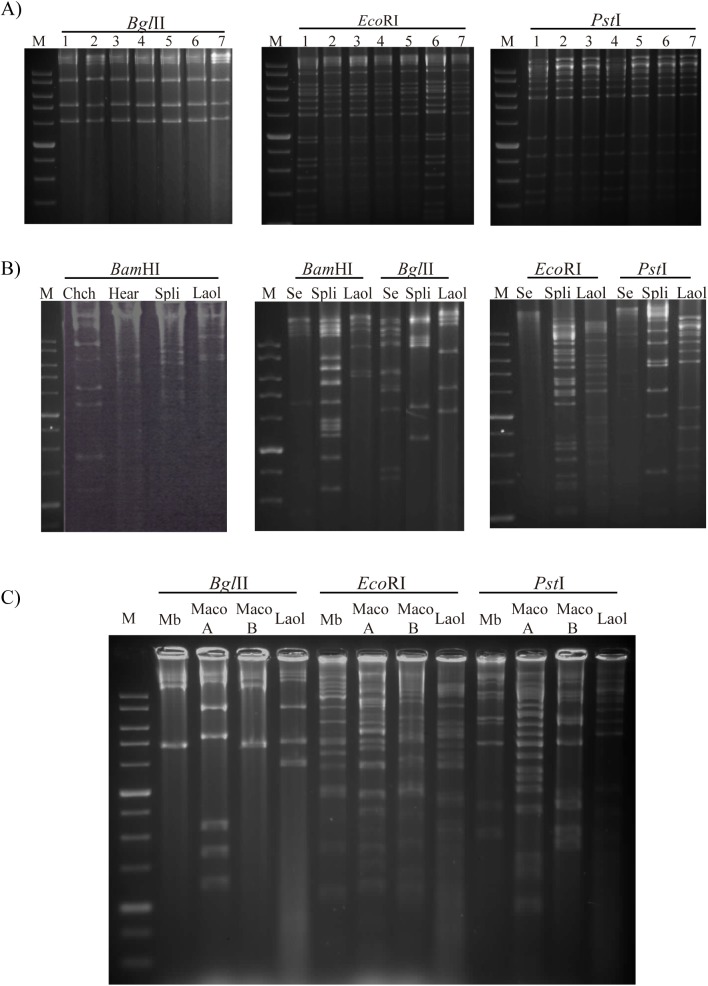
Restriction endonuclease analysis of LaolNPV DNA.Restriction endonuclease profiles following digestion of A) genomic DNAs of the seven isolates of LaolNPV collected in alfalfa crops nearby Montpellier with BglII, EcoRI and PstI enzymes, B) genomic DNAs of Chrysodeixis chalcites NPV (Chch), Helicoverpa armigera SNPV (Hear), Spodoptera littoralis (Spli), Spodopera exigua MNPV (Se) and the virus under study (LaolNPV) with BamHI, BglII, EcoRI and PstI, and C) genomic DNAs of Mamestra brassicae MNPV (Mb), Mamestra configurata NPV-A (MacoA), Mamestra configurata NPV-B (MacoB) and LaolNPV with BglII, EcoRI and PstI.